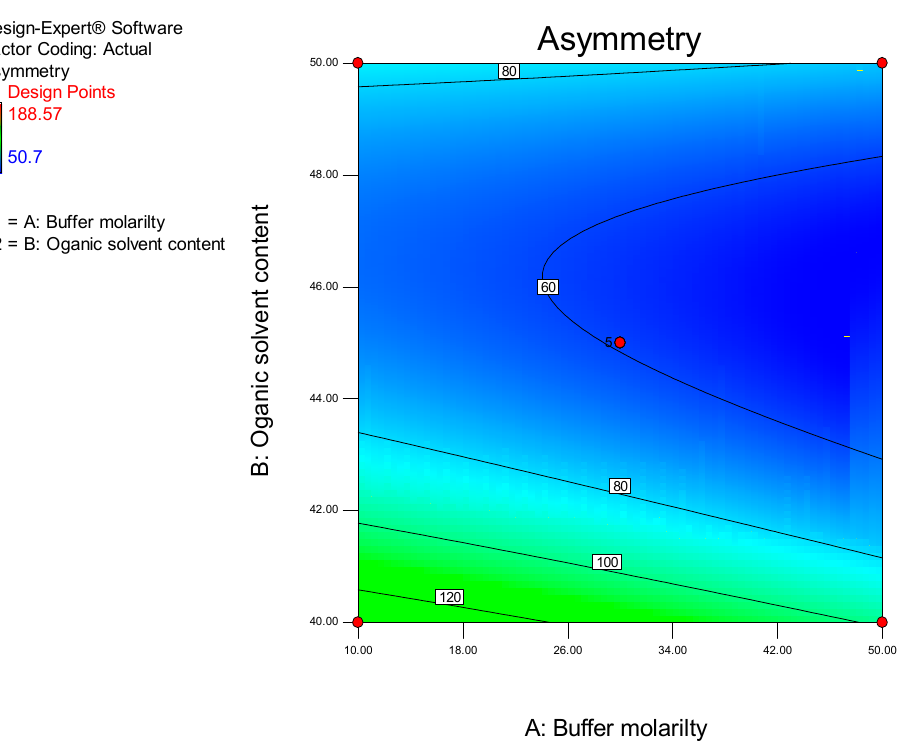
Figure 6. Contour plot depicting the impact of ACN content and buffer molarity on peak asymmetry. The best peak shape with minimal tailing can be obtained at an ACN concentration of approximately 46% v/v . Due to peak tailing, the experimental run time was increased to 20 min to permit the chromatograms to return to baseline. The equation for peak symmetry ( Y 2 ) is reported in Equation 3. 1 / Sqrt (Asymmetry) = + 0.13 + 5.545E − 003A + 4.846E − 003B − 3.690E − 003AB −